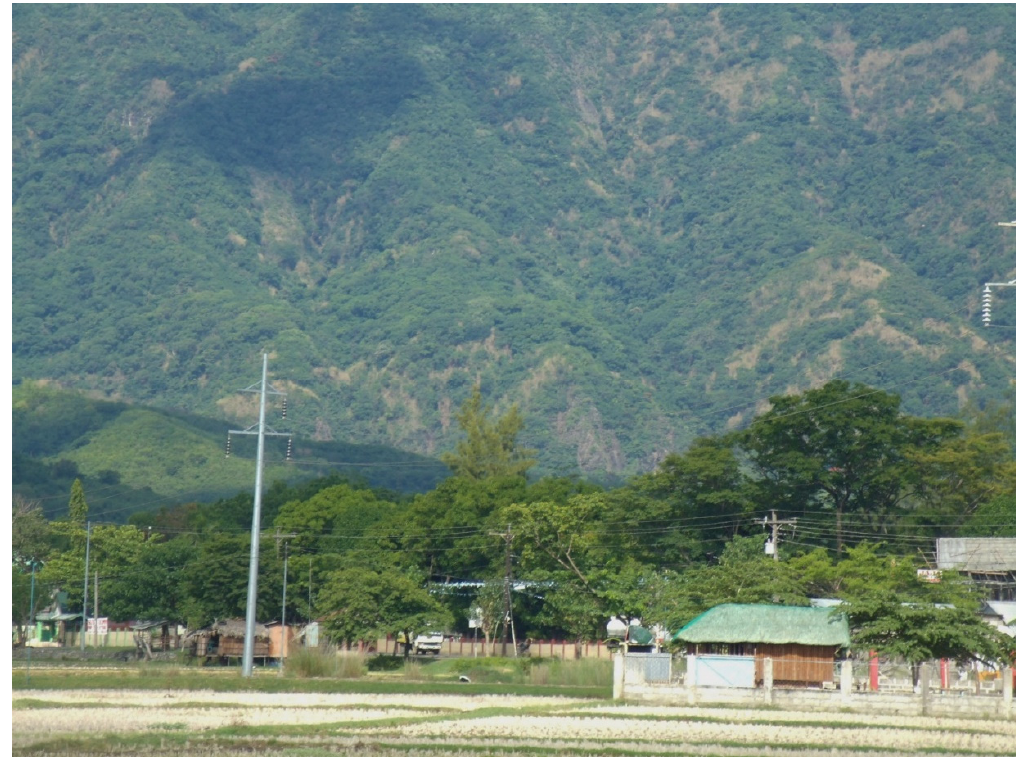
Figure 5. A series of left-laterally offset spurs in Vigan, Ilocos, Sur. Triangular facets are also prominent features. Location of the photo is indicated by a black square in Figure 3.